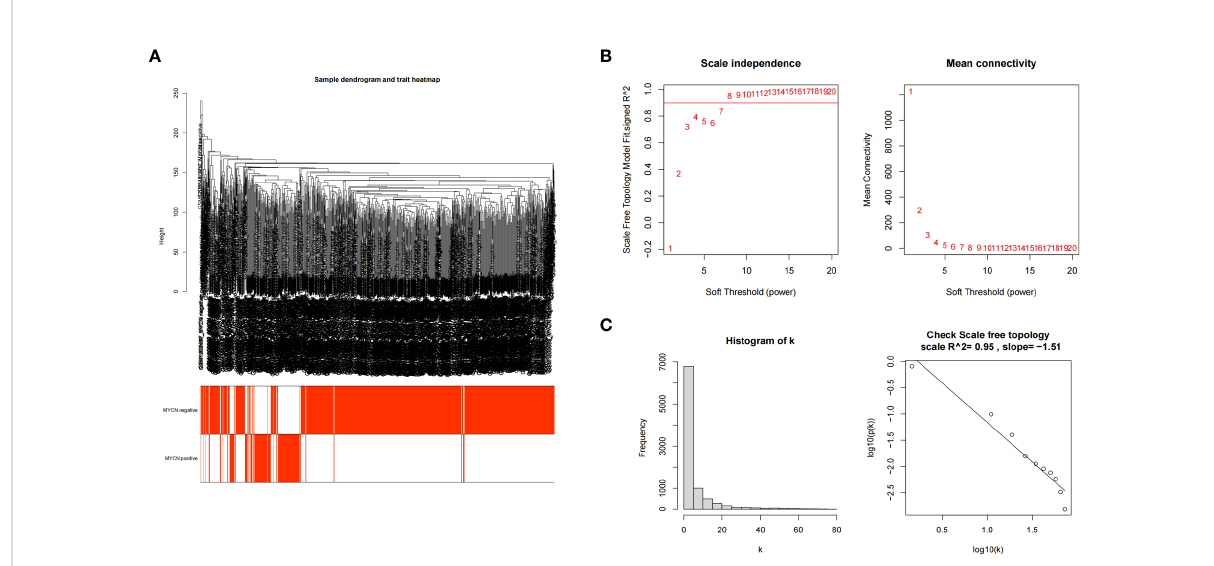
FIGURE 4 Establishment of scale-free network (A) Clustering dendrogram of 1136 samples. (B) Scale-free exponential analysis and average connectivity analysis of various soft-threshold powers ( b ). (C) Check the scale-free topology, the distribution approximately follows an approximate straight line, which is called approximate scale-free topology when b =8.